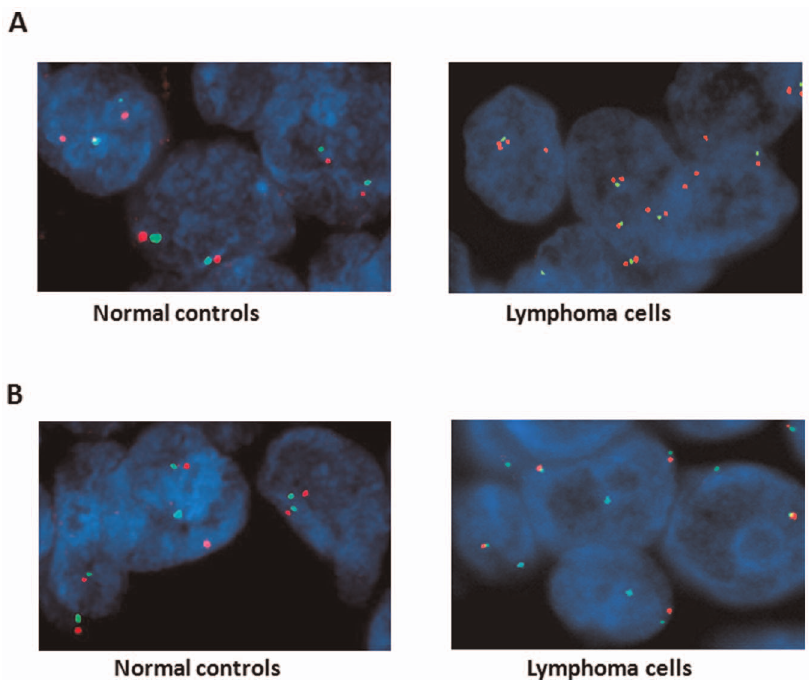
Figure 2. FISH validation of copy number variation detected by Cytoscan HD analysis. (A) Representative images of FISH analysis using probes specific for BRAF (7q34, red) and centromere of chromosome 7 (green). Left, normal diploid control, right-case 4 lymphoma (BRAF amplified). (B) Representative images of FISH analysis using probes specific for CITED2 (6q23.3, red) and centromere of chromosome 6 (green). Left, normal diploid control, right-case 2 lymphoma (CITED2 deleted). doi:10.1371/journal.pone.0092820.g002 rates based on CNV length between arrays from the matched FFPE and frozen tissues ranged from 82% to over 99%. Seven of these FFPE blocks are over 1 year old and one is 3 years. The average concordant rate for 1 year old samples is 94.1%, while the Table 4. Correlation of CNV callings and FISH on BRAF and